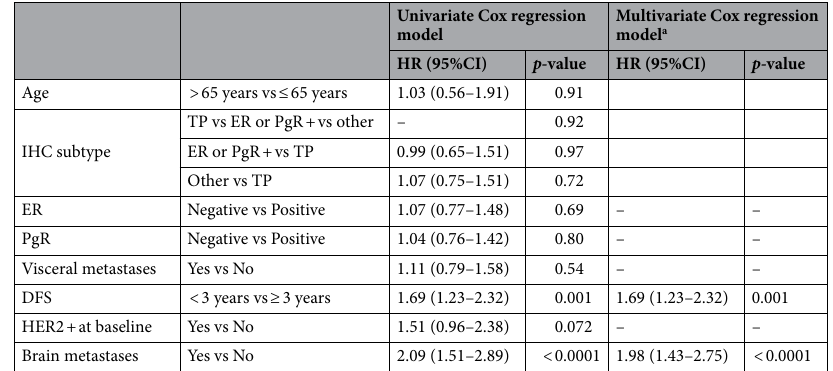
Table 2. Uni- and multivariate Cox regression models for OS. HR, hazard ratio; IHC, Immunohistochemical; TP, triple positive; ER, estrogen receptor; PgR, progesterone receptor; DFS, disease free survival. a Adjusted for the variables significant at the univariate